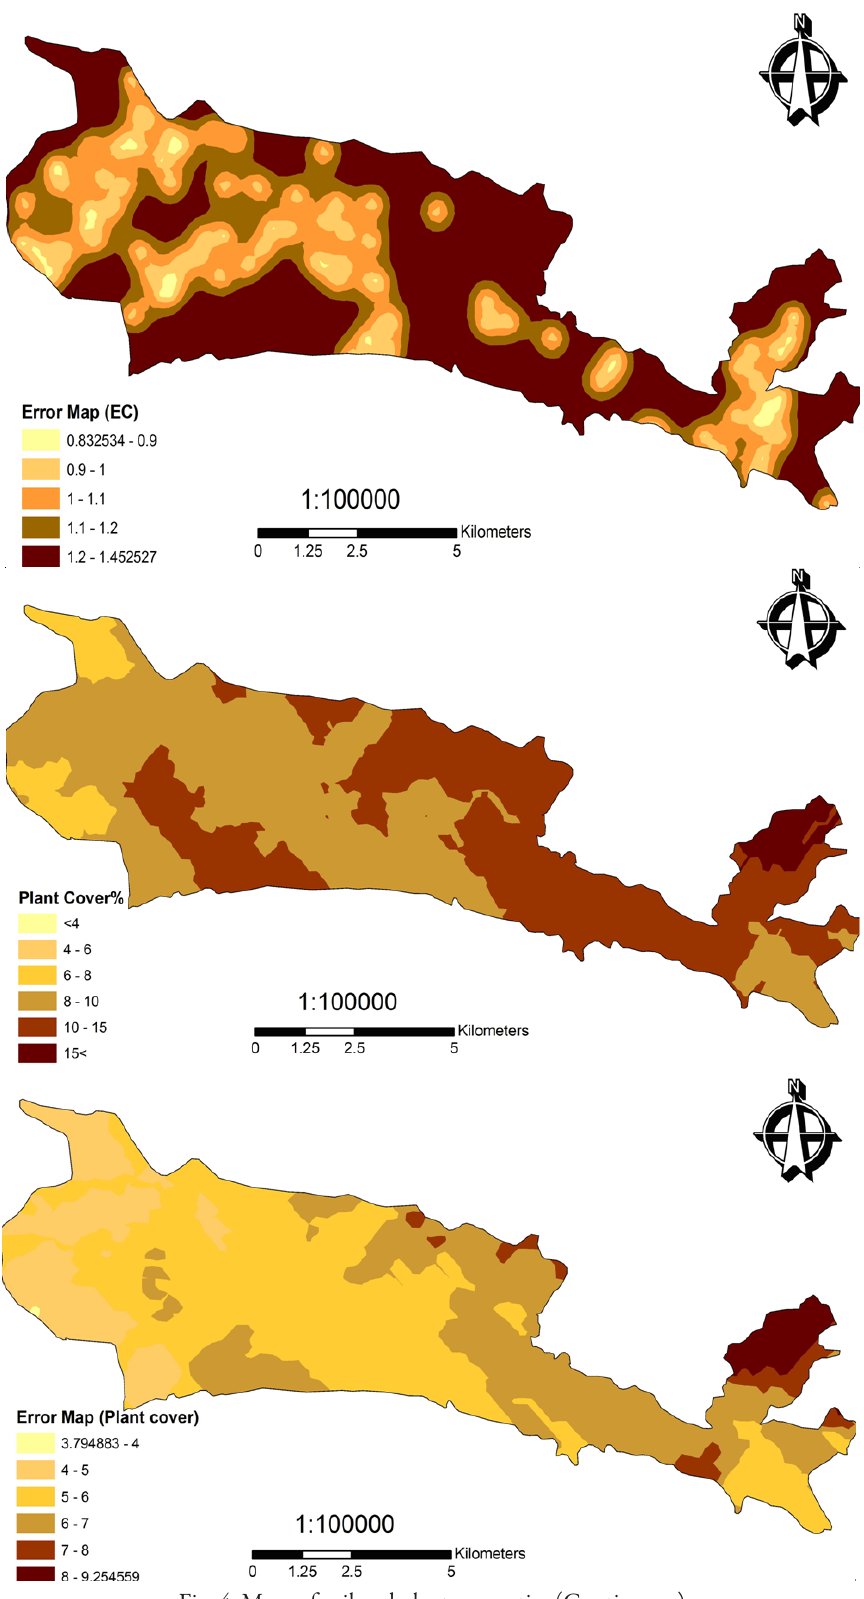
Fig. 4. Maps of soil and plant properties